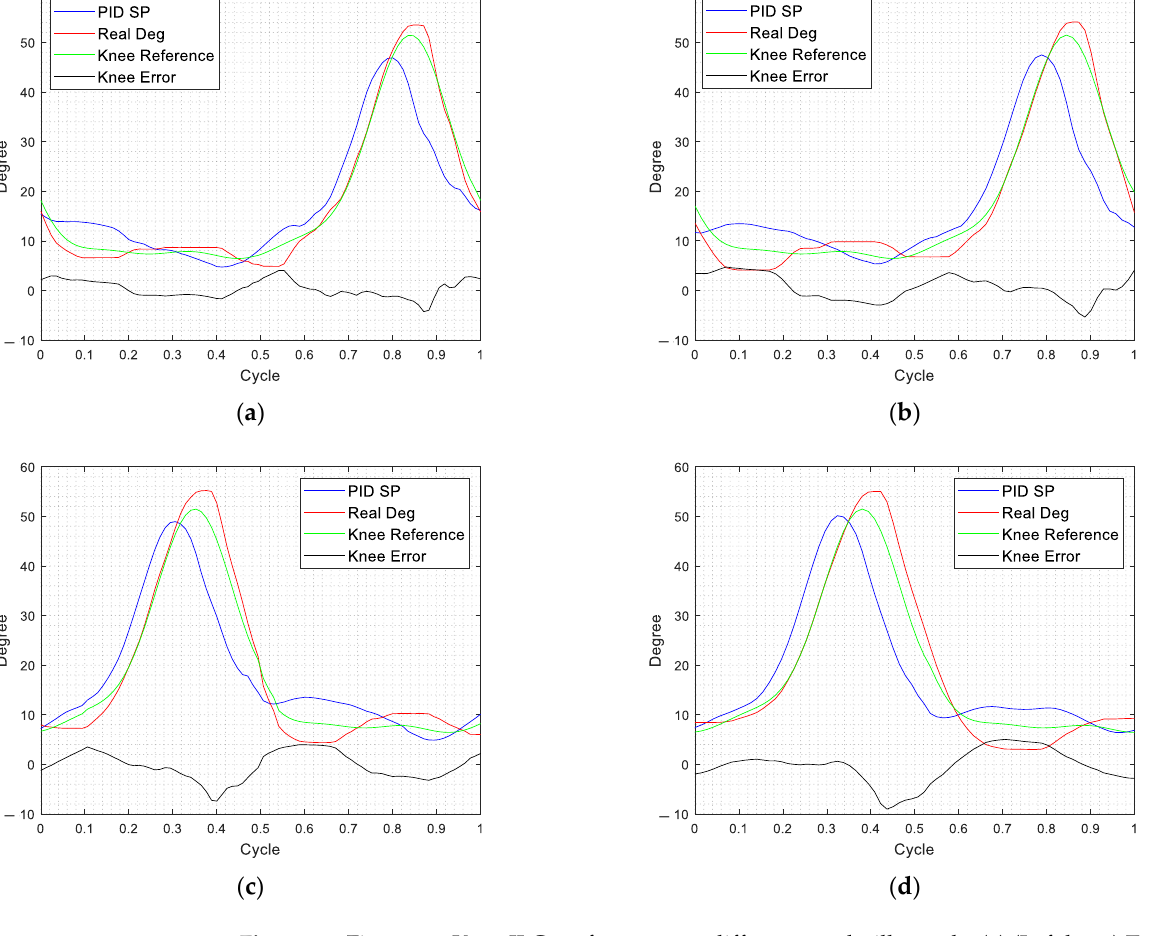
Figure 13. Knee ILC performance at different treadmill speeds. ( a ) (Left knee) Treadmill speed 0.85 km/h; ( b ) (Left knee) Treadmill speed 1 km/h; ( c ) (Right knee) Treadmill speed 0.85 km/h; ( d ) (Right knee) Treadmill speed 1 km/h.